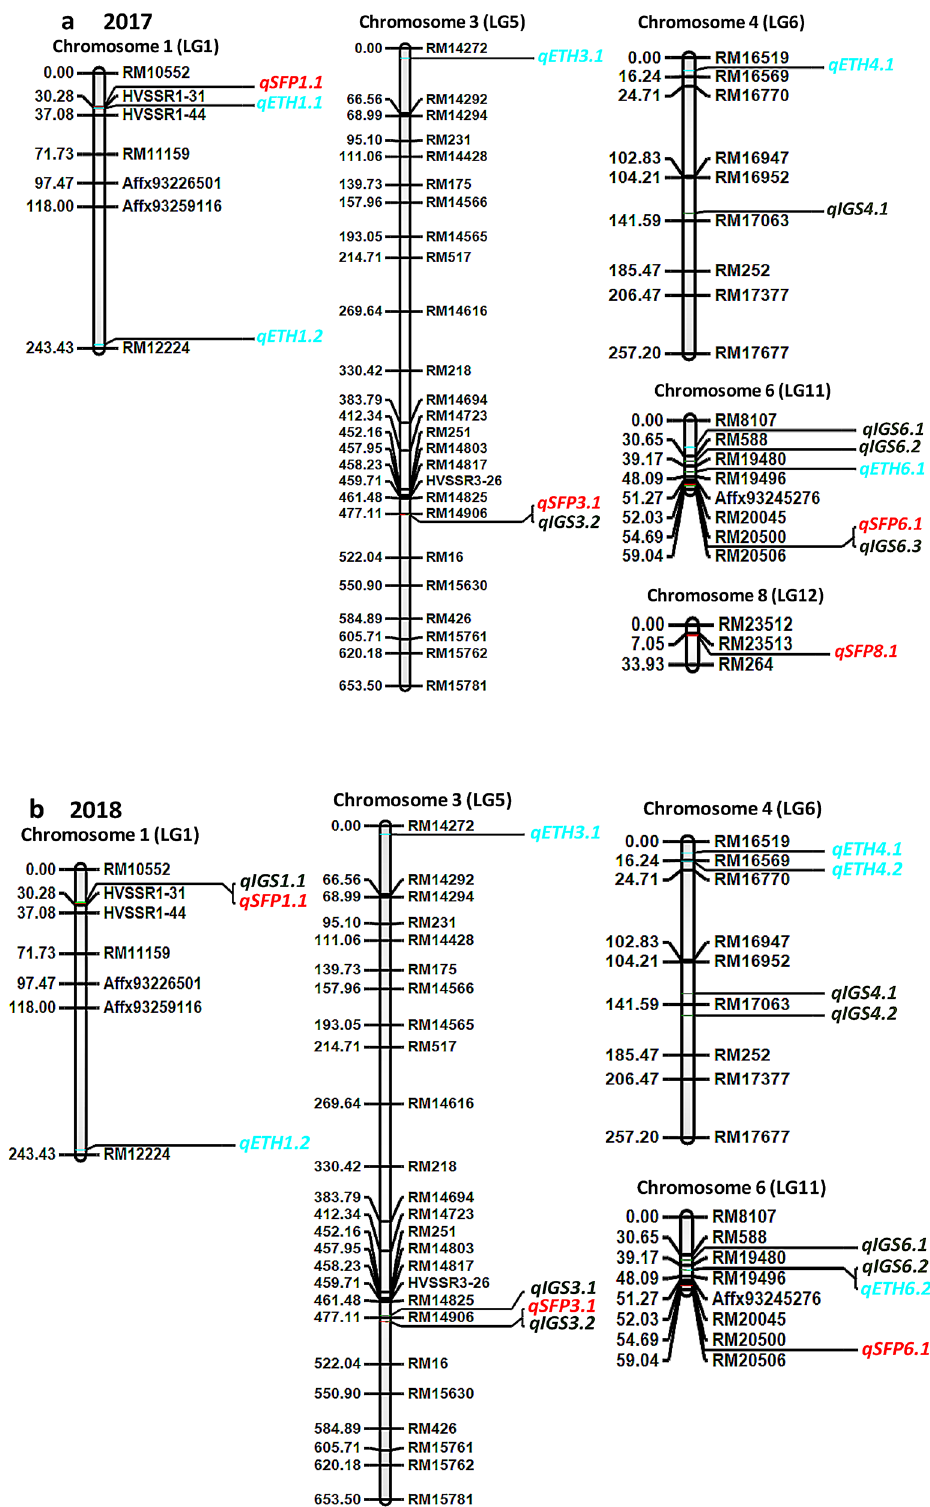
Figure 4. Linkage map showing QTLs associated with spikelet fertility (SFP), inter-grain space (IGS) and ethylene production (ETH). QTL identification was done using integrated QTL IciMapping, Version 4.1 software for ( a ) kharif 2017, and ( b ) kharif 2018. Markers and QTLs are represented on right side of linkage group, while values on left side represented linkage distance in cM, LG-Linkage